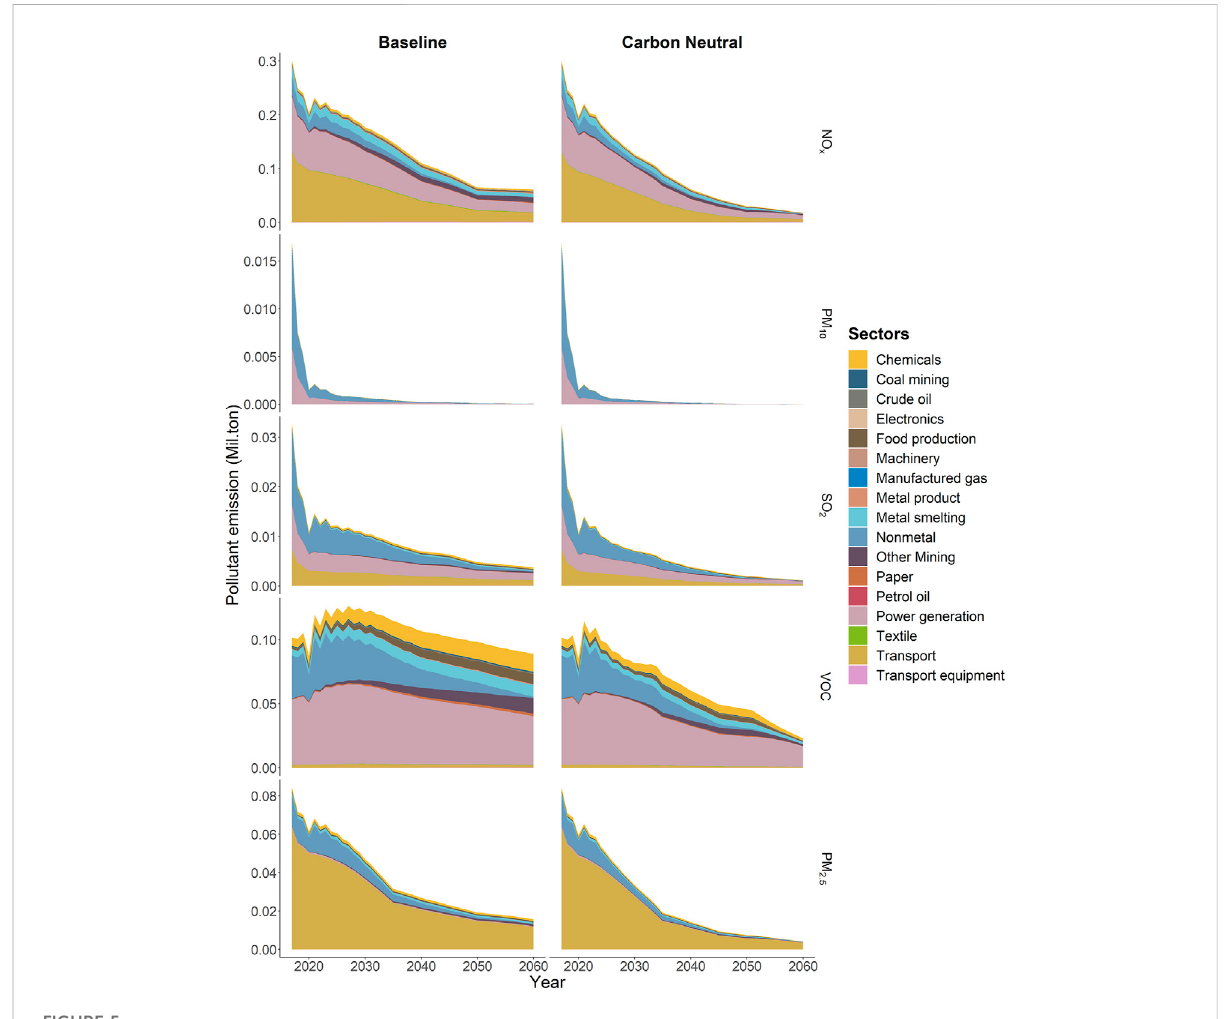
FIGURE 5 Air pollutants emission reduction of main sectors in